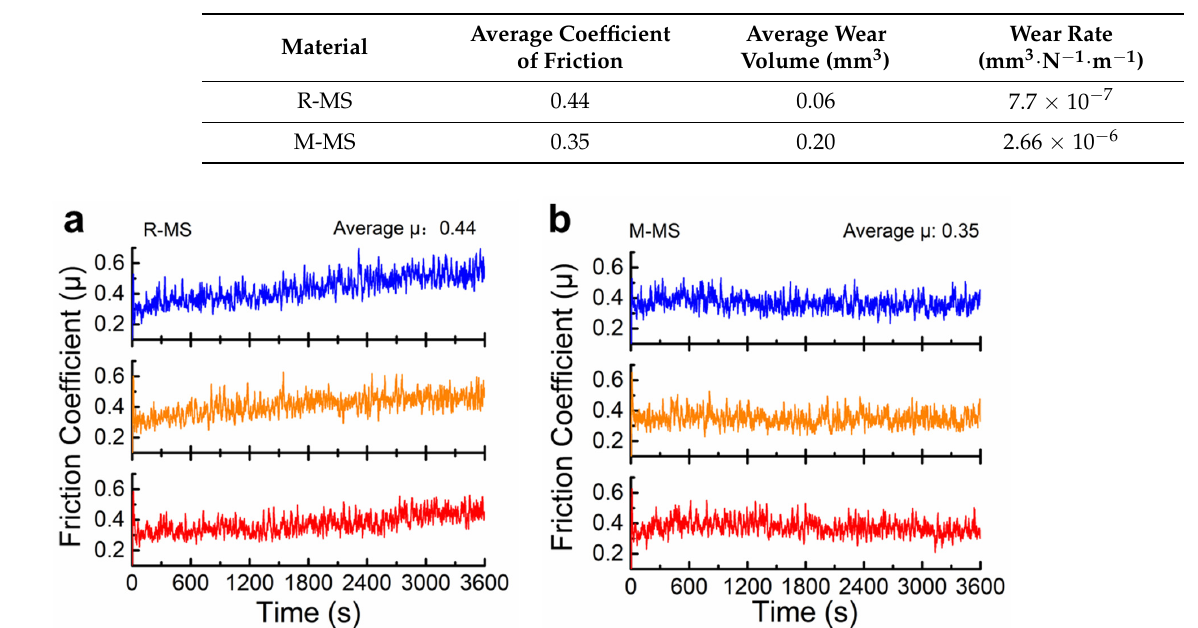
Figure 6. Average friction coefficient of MCMCB-SiC composites: ( a ) R-MS; ( b ) M-MS.